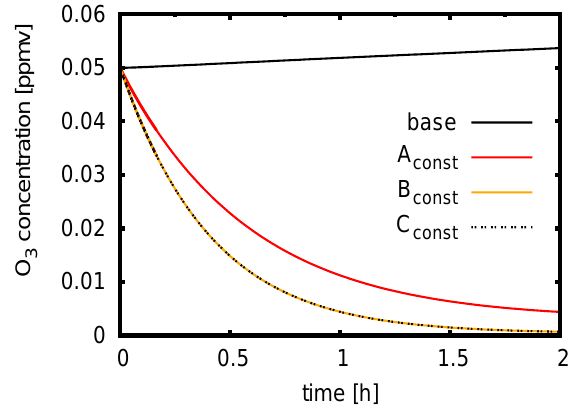
Fig. 8. The temporal evolution of the gas-phase O 3 concentration is shown for a base scenario with no hetero- geneous chemistry and for the constant uptake scenarios A const , B const , C const . Scenarios A const , B const , C const use constant uptake coefficients of γ O =1 × 10 − 3 (Stephens et al., 1986; P¨oschl et al., 2001), 3 γ NO = 0 . 14 (Gerecke et al., 1998; Ammann and P¨oschl, 2007), and γ H = 0 . 4 × 10 − 3 (Rogaski et al., 2 2 O 1997; P¨oschl et al., 2001) but are otherwise equivalent to scenarios A, B, and C as defined in Table 1.